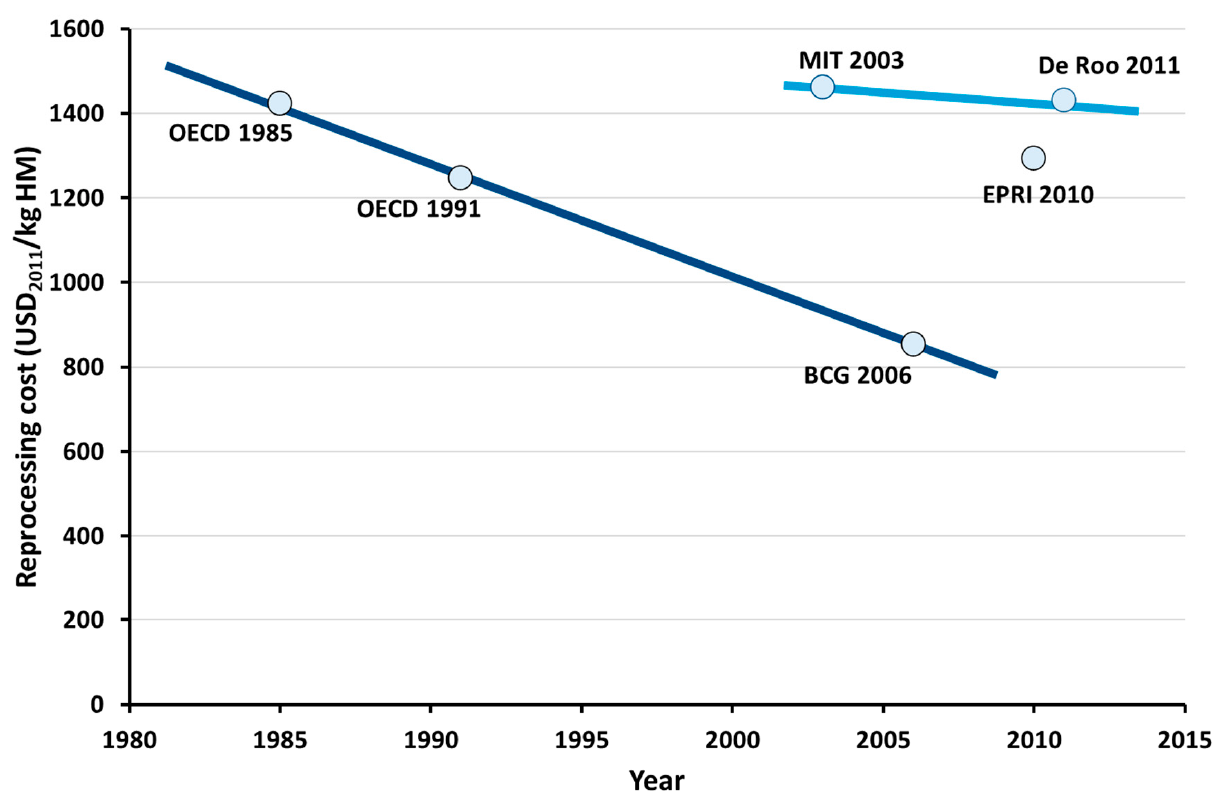
Figure 7. Reprocessing cost trends in the TTC based on analysis in [62].